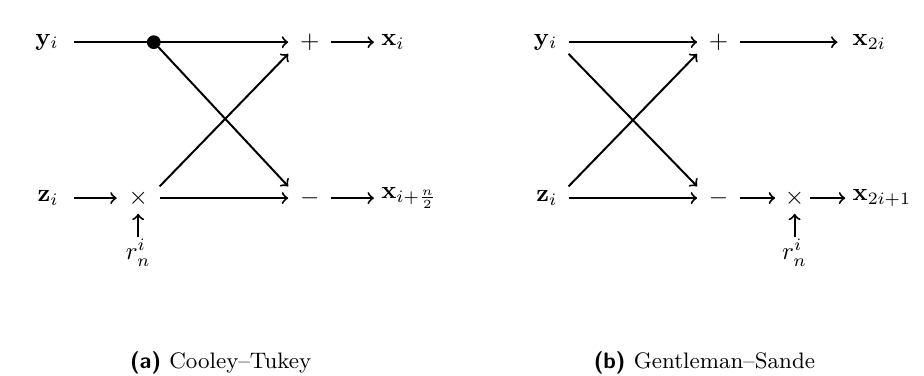
Figure 1: Butterfly diagrams for the Cooley–Tukey and Gentleman–Sande FFT